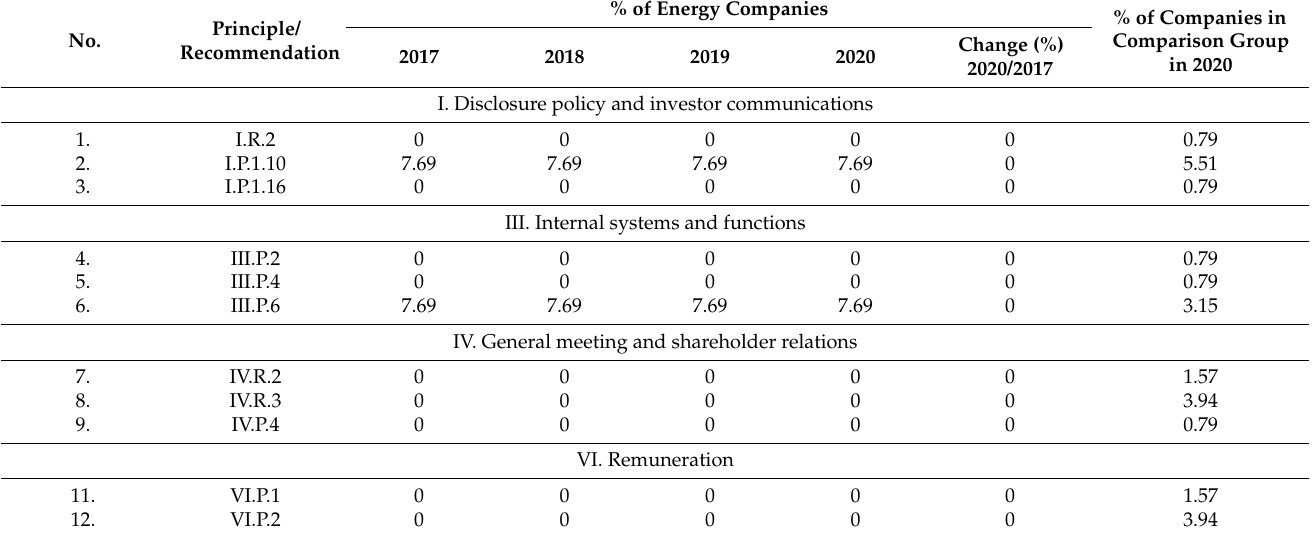
Table 5. Recommendations and principles not applicable to analysed